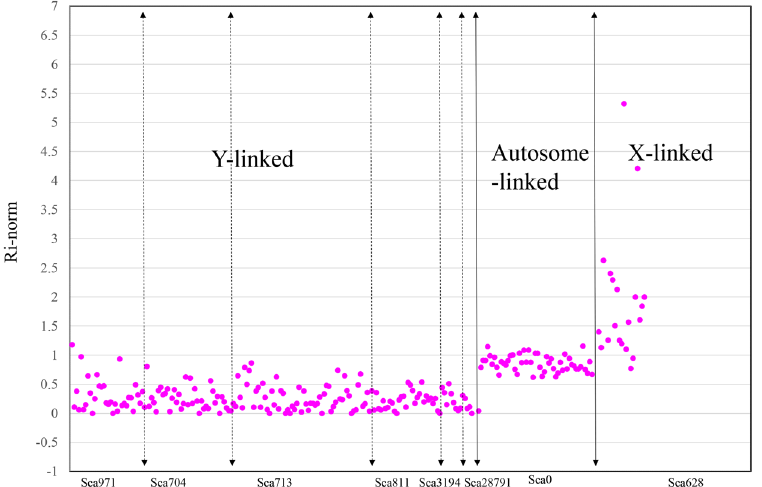
Figure 2. Discrepancy of R i -norm distribution among fragments that originated from different chromosomes. Pink circle indicates R i -norm values of fragments. The x axis represents different fragments, and the y axis represents R i -norm value. Scaffolds are shown by their ID numbers. Compared with autosome-linked scaffolds that with R i -norm value of ~1, Y-linked scaffolds have lower R i -norm value (~0), whereas X-linked scaffolds have higher R i -norm value (~2).